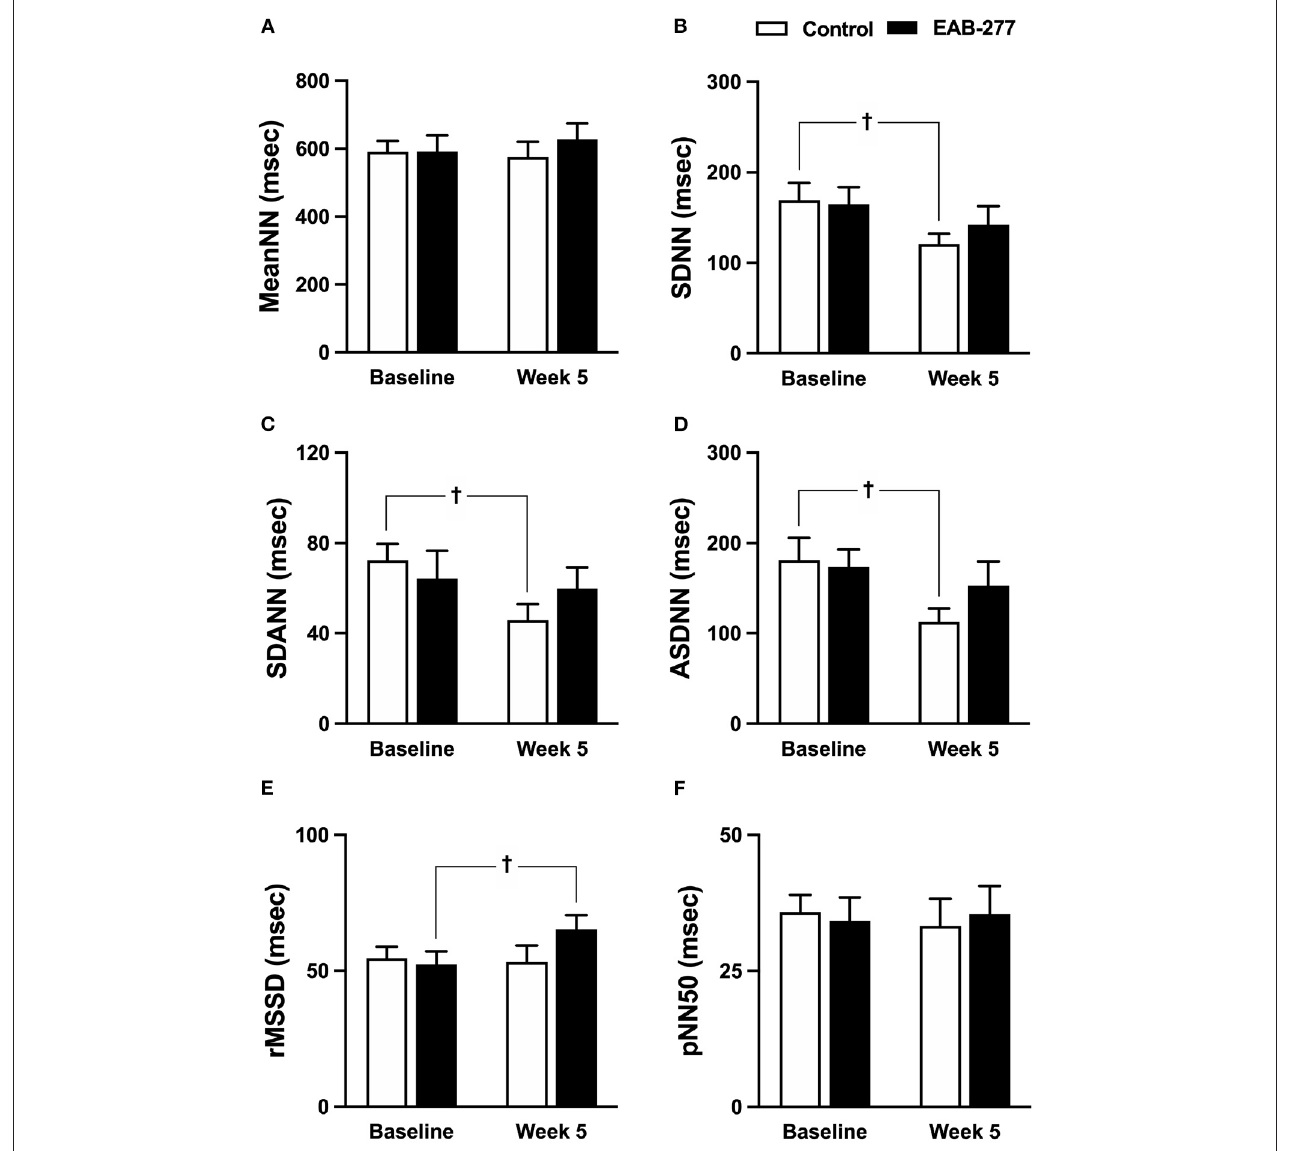
FIGURE 5 | Effect of standard treatment and EAB-277 ® on time-domain heart rate variability in tracheal collapse dogs. Time-domain HRV demonstrated that (A) mean NN, (B) SDNN, (C) SDANN, (D) ASDNN, (E) rMSSD, and (F) pNN50 were not different in the two groups at baseline. In the control group, SDNN, SDANN, and ASDNN were decreased at week 5 compared to baseline. In the EAB-277 ® group, (E) rMSSD was increased at week 5 compared to baseline, whereas mean NN, SDNN, SDANN, ASDNN, and pNN50 were not different before and after treatment. Mean NN, mean of N-N intervals; SDNN, standard deviation of all normal R-R intervals; SDANN, standard deviation of the averaged N-N intervals for all 5-min segments; ASDNN, average of the 5-min standard deviations of N-N intervals; rMSSD, Square root of the mean of successive N-N intervals differences and pNN5, the percentage of successive N-N intervals > 50 msec. † P ≤ 0.05 compared to baseline in the same